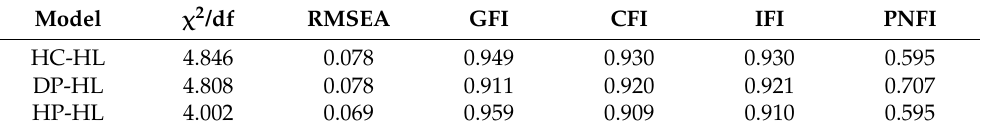
Table 4. Construct validity of CPHLQ-Physical Part. Model